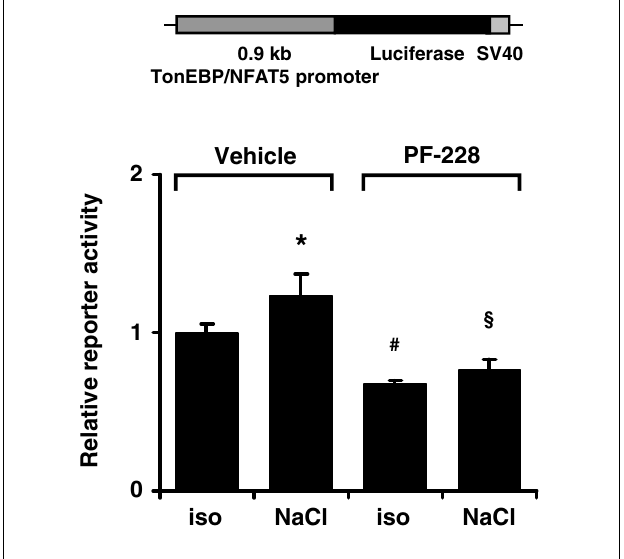
FIGURE 9 | Effect of FAK inhibition on TonEBP/NFAT5 promoter activity. HEK293 cells were transfected with a reporter construct containing 0.9kb of the human TonEBP/NFAT5. Subsequently, the cells were incubated for 24h in isotonic (300mosm/kg H 2 O) or hypertonic medium (500mosm/kg H 2 O by NaCl addition) in the presence of 10 μ M PF-228 or only vehicle ethanol. Thereafter, reporter activity was determined as described in Methods. Means ± s.e.m. for n = 4 ∗ p < 0 . 05 vs. iso + vehicle; # p < 0 . 05 vs. iso + vehicle; § p < 0 . 05 vs. Nacl + vehicle.